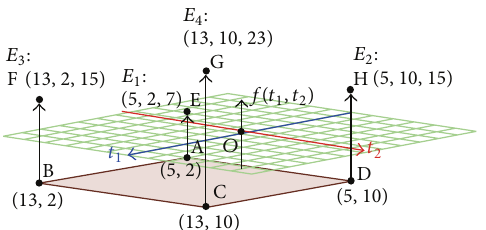
Figure 3: Hyperrectangle schema of embedded system with two tasks.